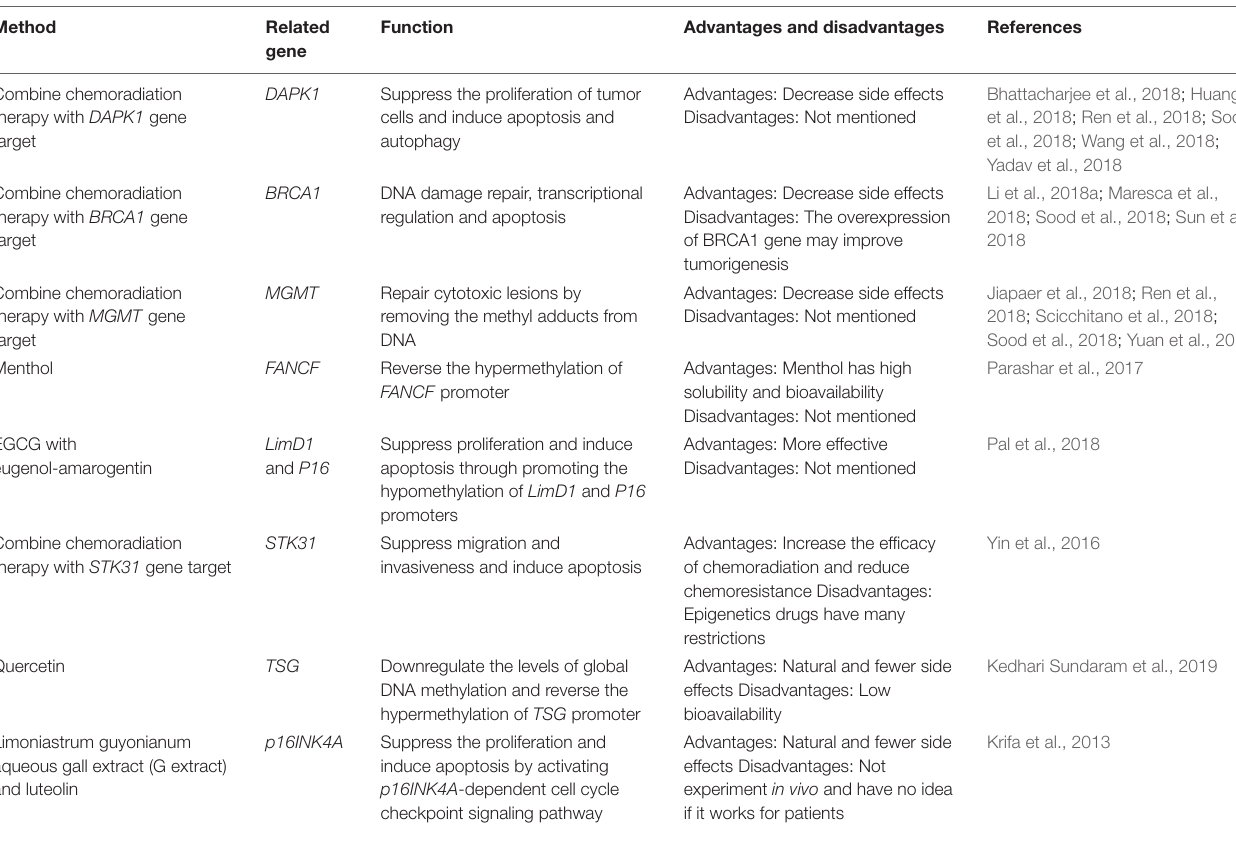
TABLE 3 | The summary of the potential methylation